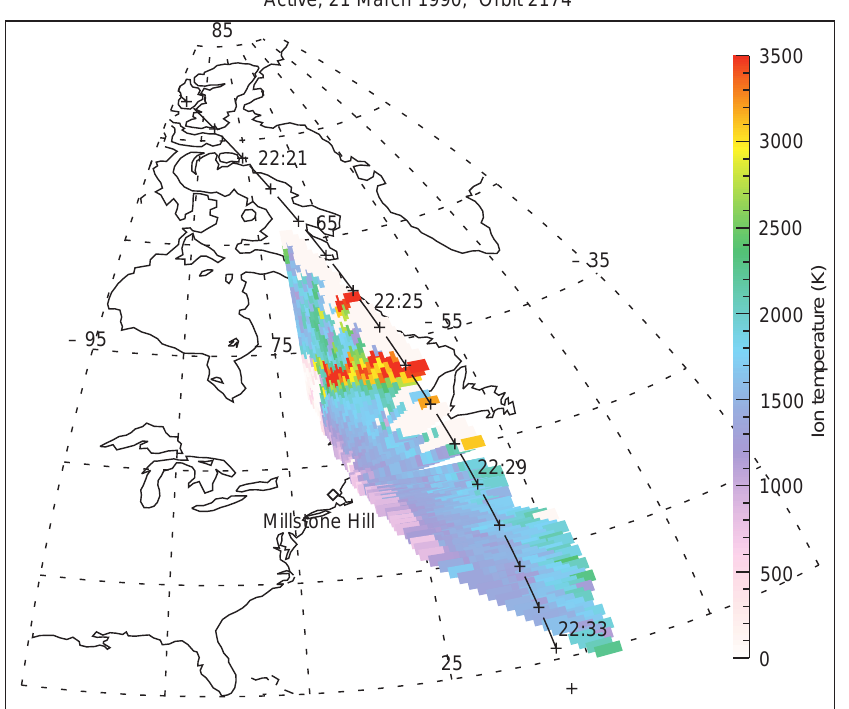
Fig. 4. The descending orbit 2174 of the Active main satellite on March 21, 1990, during its passage E of the Millstone Hill incoherent scatter radar station (location indicated by diamond ). The ion tempera- ture measurements of the simultaneous azimuth-elevation-scan of the radar are shown in geographic latitude and longitude coordinates. According to the beam geometry they represent di(cid:128)erent